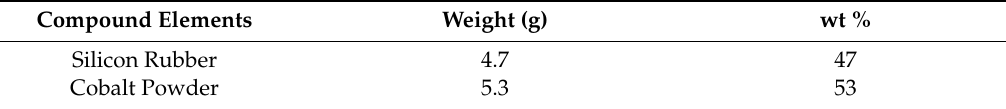
Figure 1. Schematic diagram of magnetorheological elastomer (MRE) preparation. Table 1. Component of cobalt-based magnetorheological elastomer